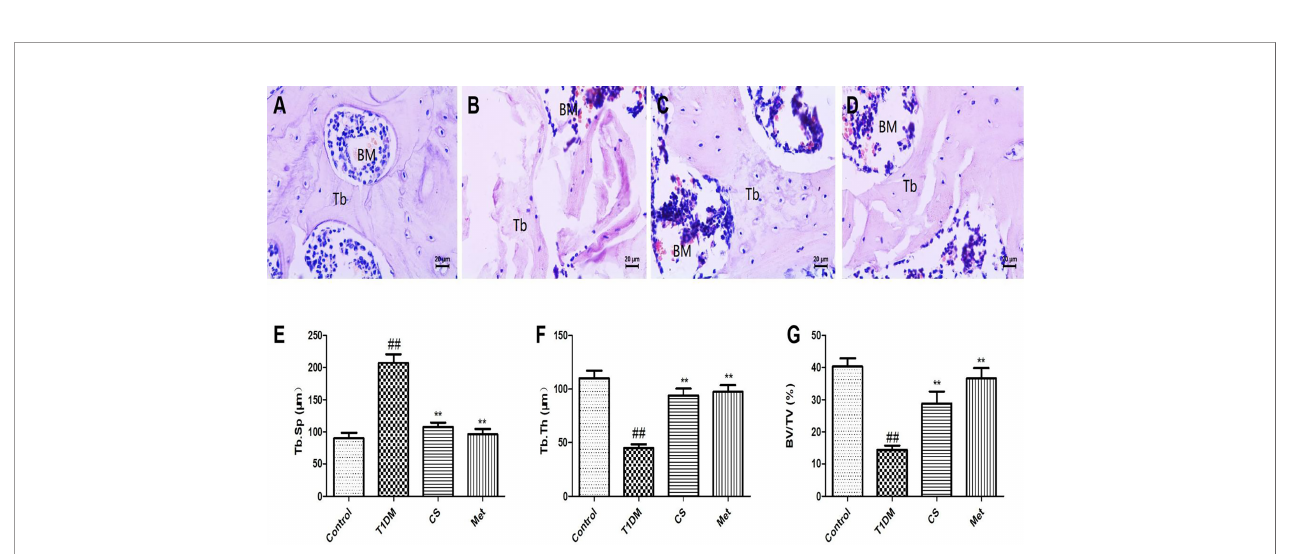
FIGURE 6 | The pathological sections of femur of rats in each group at the end of the 10th week; paraf fi n section of femur was stained with hematoxylin and eosin, 400×. (A) The control group femur. (B) The diabetic group femur. (C) The CS group femur. (D) The Met group femur. (E) The trabecular separation (Tb·Sp) in different groups. (F) The femoral thickness (Tb·Th) in different groups. (G) The percentage of bone trabecular area (BV/TV) in different groups; ## indicates p < 0.01 compared with control. **indicates p < 0.01 compared with the diabetic group. BM. Bone marrow; Tb. Trabecular